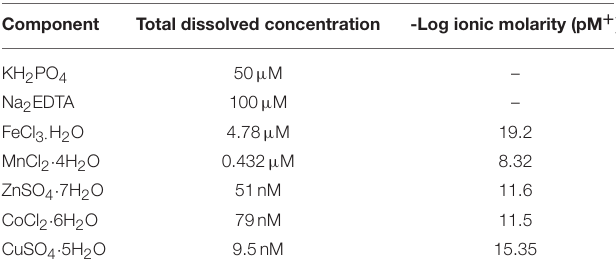
TABLE 2 | Nominal macro and micronutrient concentrations in pCu 15.95 control